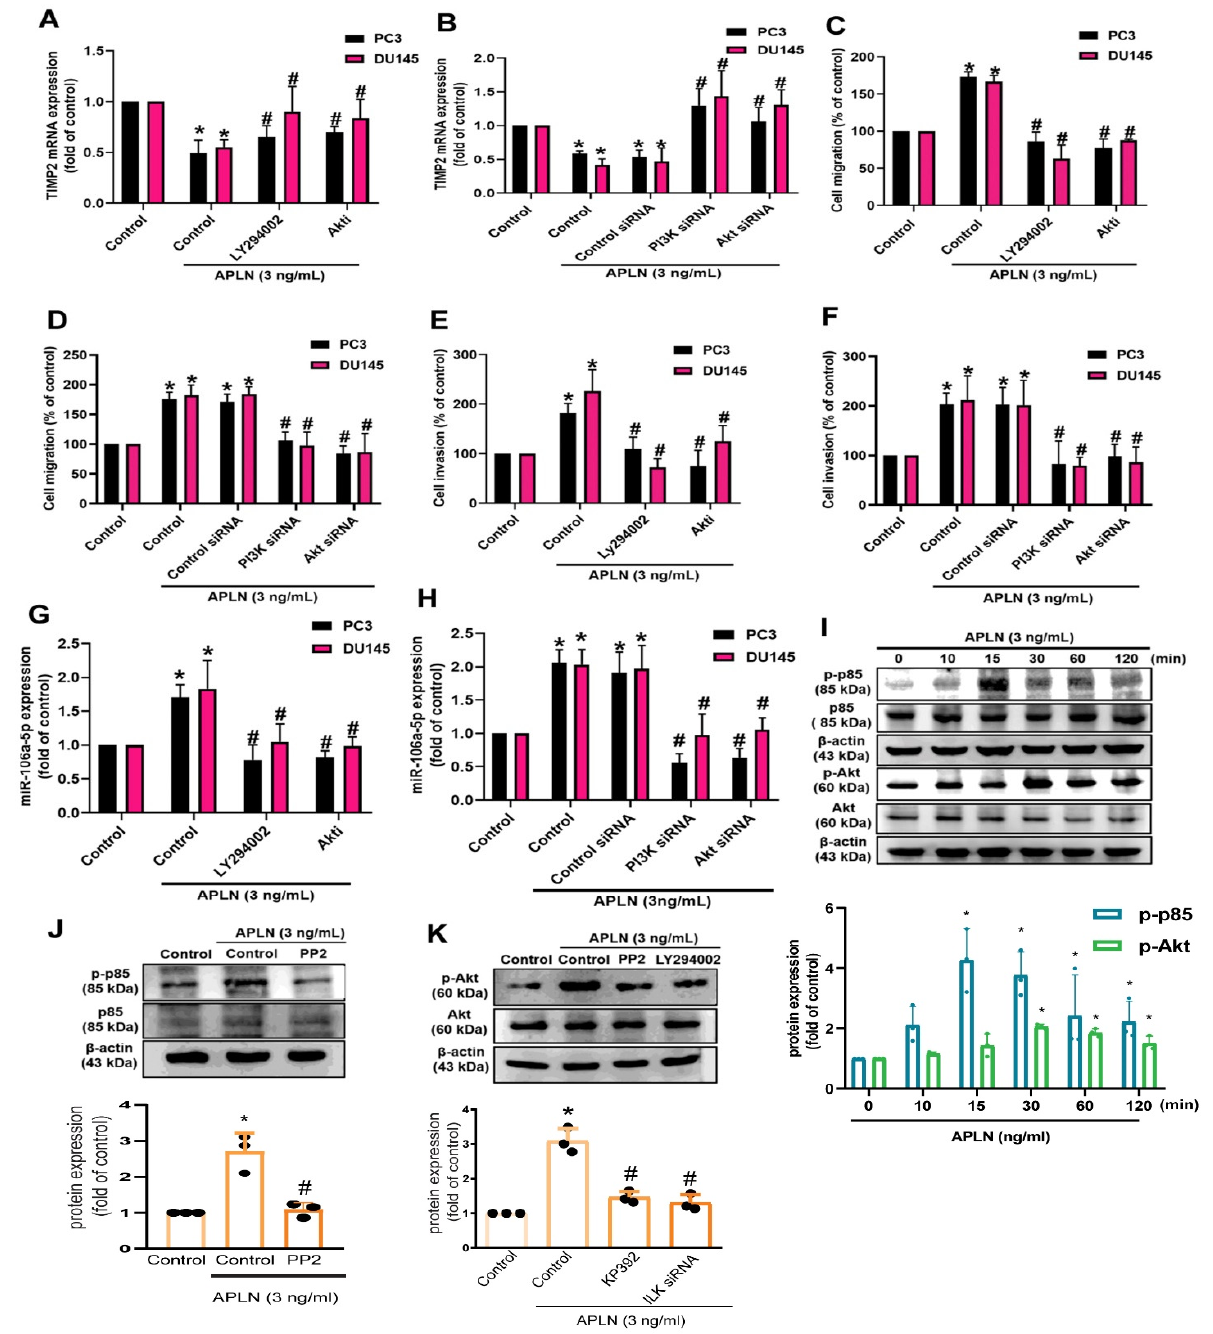
Figure 6. The PI3K/Akt pathway is involved in apelin-induced motility of prostate cancer cells. ( A – H ) Cells were applied with inhibitors of PI3K (LY294002; 2 µ M) and Akt (2 µ M), or transfected with PI3K and Akt siRNAs, then applied with apelin, before examining cell migration ( n = 4) and invasion ( n = 4), TIMP2 and miR-106a-5p expression ( n = 4). ( I – K ) PC3 cells were treated with apelin or pretreated with c-Src and PI3K inhibitors then applied with apelin for 30 min, before examining PI3K and Akt phosphorylation by Western blot ( n = 3). * p < 0.05 compared with the control group; # p < 0.05 compared with the apelin-treated group. Dots of bar graph means the repeat number of Western blot assay.